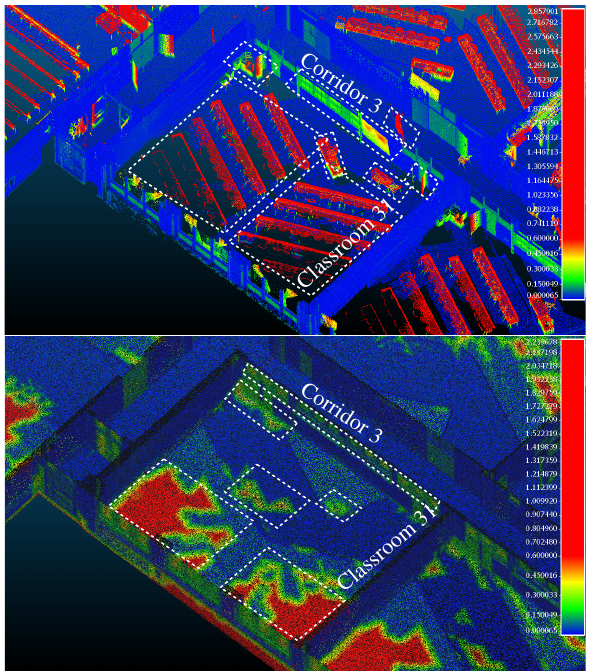
Figure 1. Results from CloudCompare (macro scale) - focus on classroom 31 and corridor 3 Top: ‘model point cloud’ as reference (BIM compared to point cloud), non-modeled objects are marked Bottom: original point cloud as reference (point cloud compared to BIM), occluded areas are marked (deviations in [m])